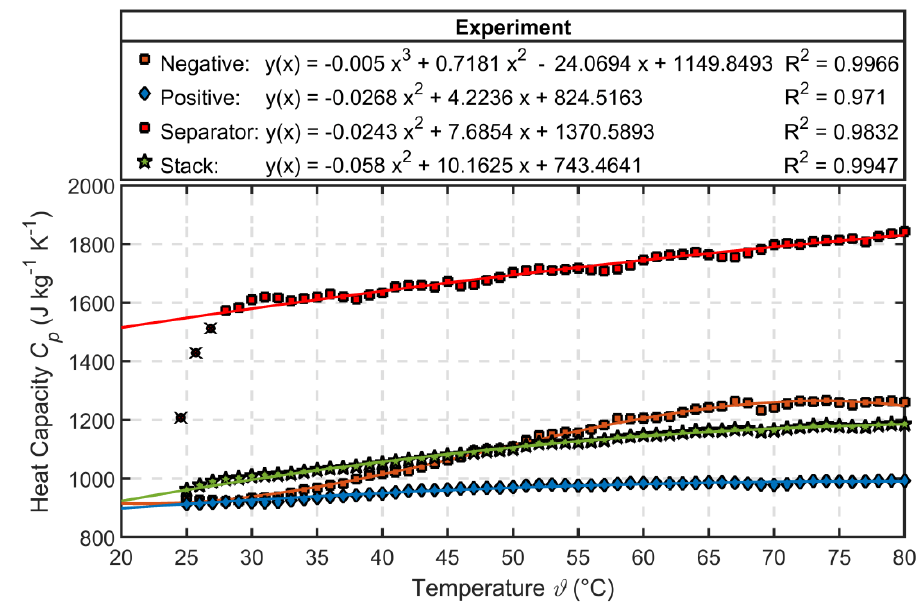
Figure 3. The specific heat capacity 𝐶 𝑝 of each component of the electrode stack is shown as a function of the temperature 𝜗 (°C) defined using Differential Scanning Calorimetry (DSC)